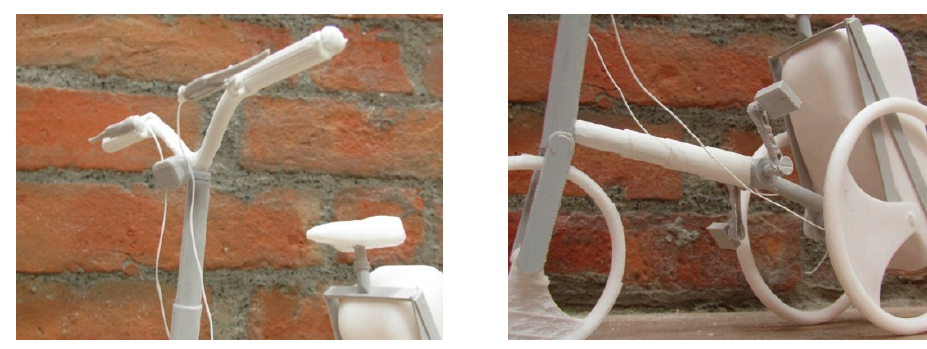
Figure 22. 3D printing bike.